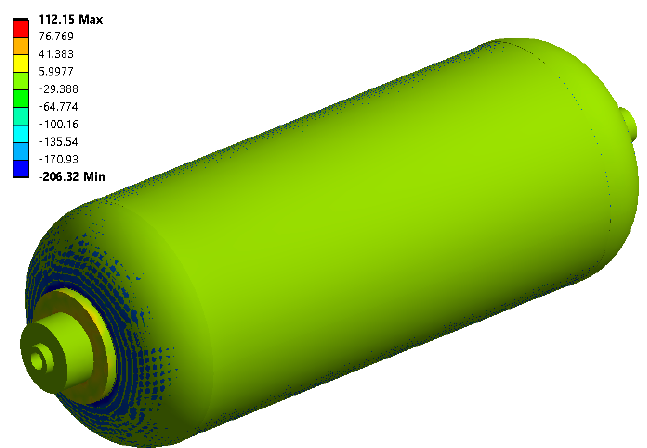
Figure 7. The contour of principal stress in the initial design of the CNG tank.